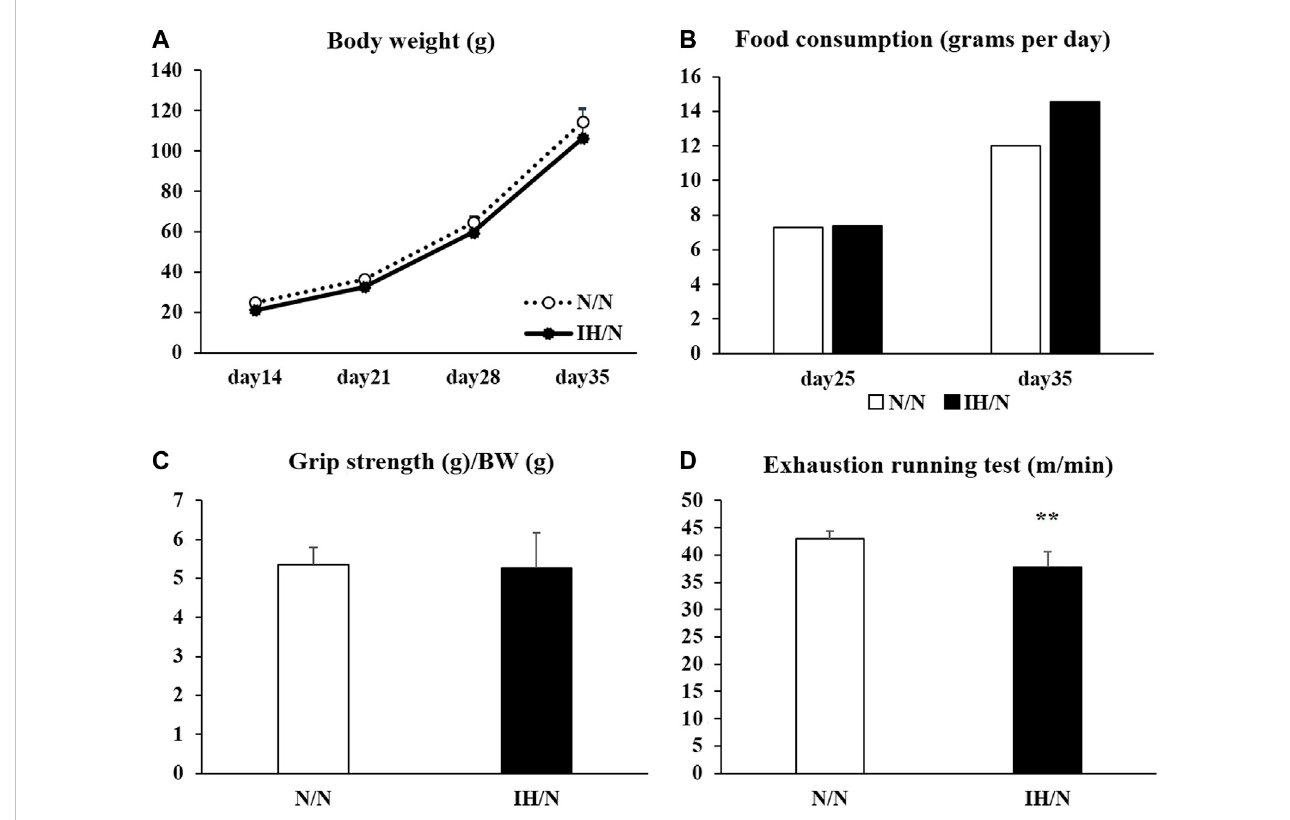
FIGURE 1 Changes in body weight, food intake, grip strength, and running to exhaustion treadmill test of offspring adolescent rats (N/N and IH/N groups). (A) WeeklyaveragebodyweightsofN/NandIH/Nratsfromday14today35afterbirthwereshown. (B) FoodconsumptionofN/NandIH/Nrats,measuredonday 25 and day35after birth, was similar. (C) Grip strength normalized to body weight showed no signi fi cant difference between N/N and IH/N rats on day35. (D) IH/N rats had signi fi cantly lower scores on the treadmill running test compared with N/N rats ( n = 6 in each group) ** p <